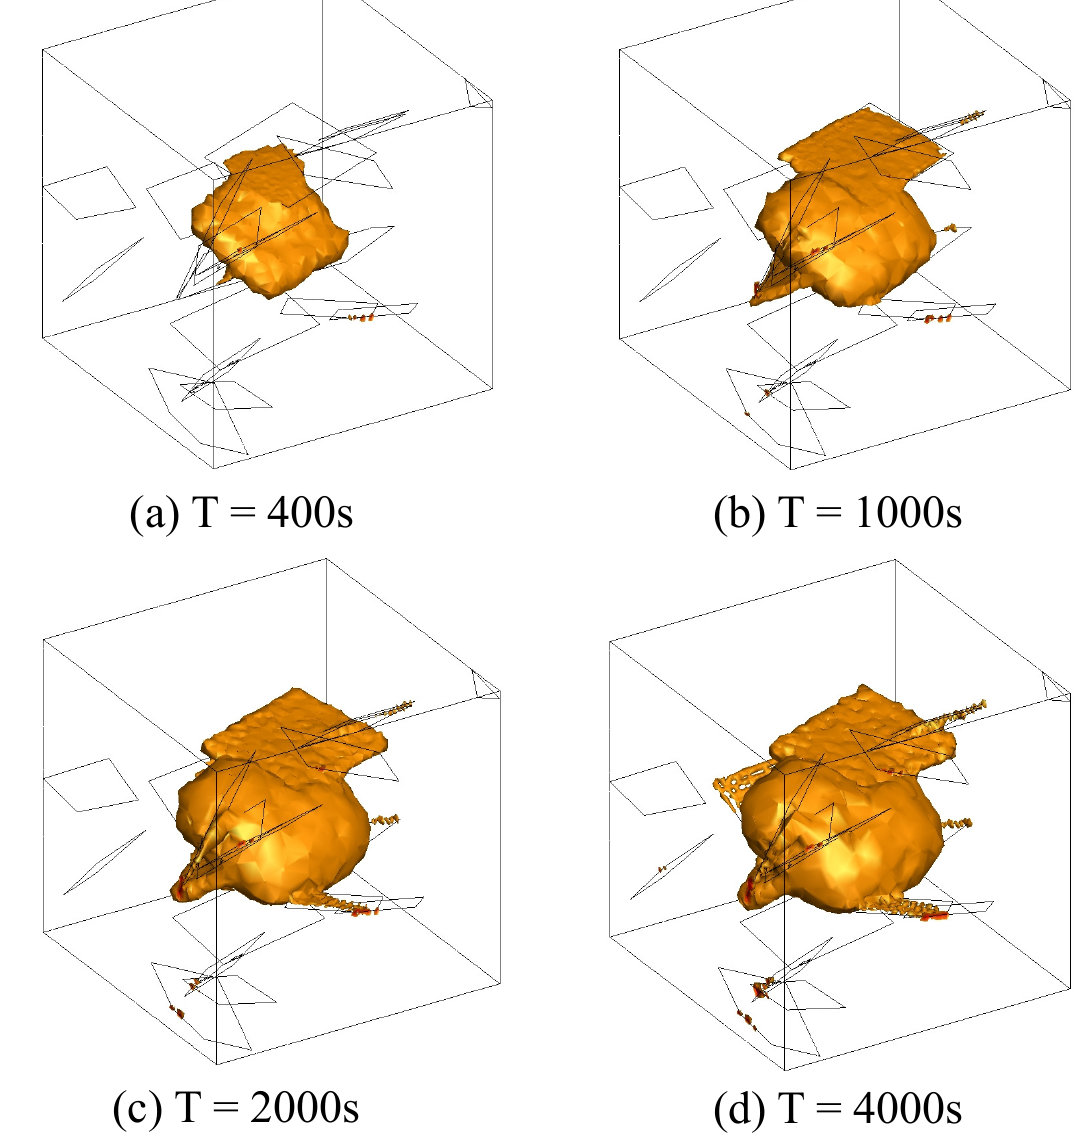
Figure 15. Grout penetration processes at different time steps with a constant injection pressure (P = 50 kPa) in a fractured and porous rock considering